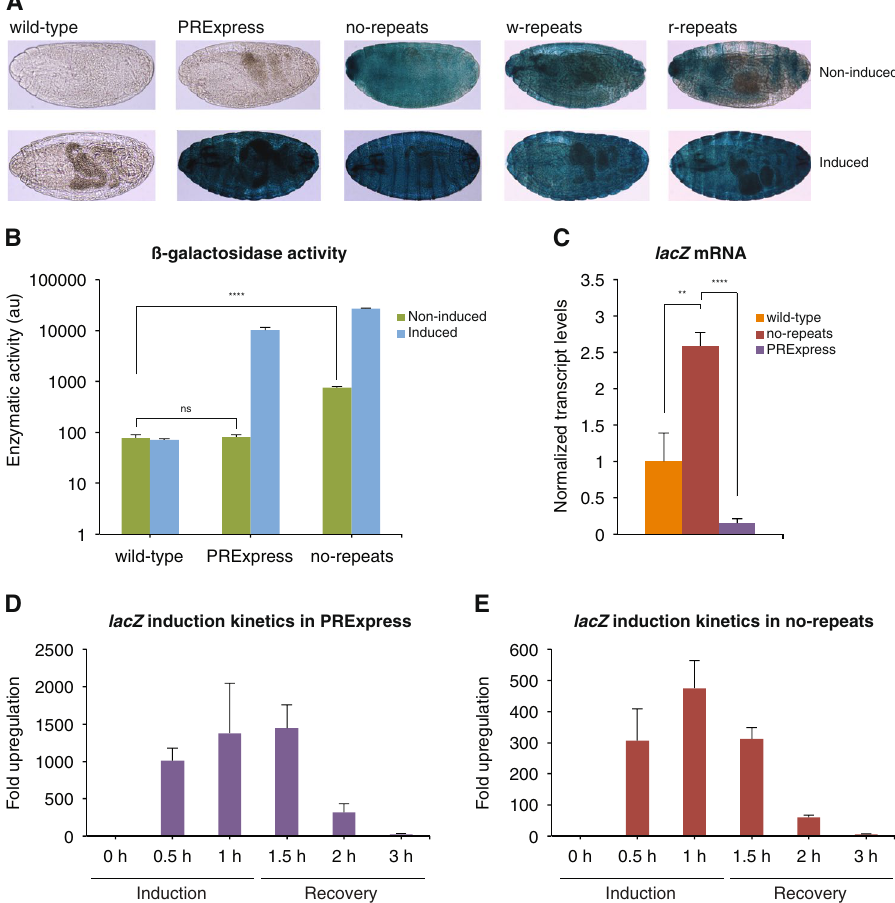
Figure 2. PRExpress in embryos. ( A ) X-gal staining of non-induced and induced embryos. ( B ) β -galactosidase activity of protein extracts from wild-type, PRExpress, and no-repeats embryos. PRExpress showed no evidence of leakiness, while no-repeats control had 10-fold higher activity compared to wild-type. Statistical significance of comparisons between non-induced and induced wild-type, PRExpress, and no-repeats samples is given in Supplementary Table 1. ( C ) Non-induced lacZ transcript levels in wild-type, no-repeats, and PRExpress embryos. At the mRNA level, no-repeats control showed higher levels of lacZ mRNA compared to wild- type and PRExpress, while PRExpress showed no evidence of leakiness. The values for lacZ mRNA were first normalized to RpL32 and then to the average of normalized wild-type values. ( D , E ) Kinetics of lacZ mRNA induction in PRExpress and no-repeats embryos. Both lines showed rapid and reversible induction of the reporter. The embryos were induced for 1 hour and then allowed to recover for up to 2 hours. The values for lacZ mRNA were normalized to RpL32 and the 0 h time point values. NS – P > 0.05, * P ≤ 0.05, ** P < 0.01, **** P < 0.0001, n =